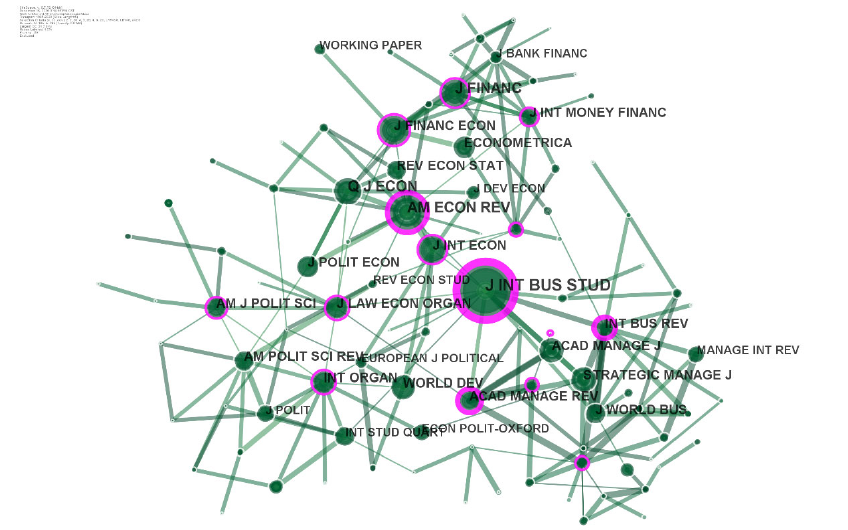
Fig . 8. Co-cited graphs of journals of political risk related papers in